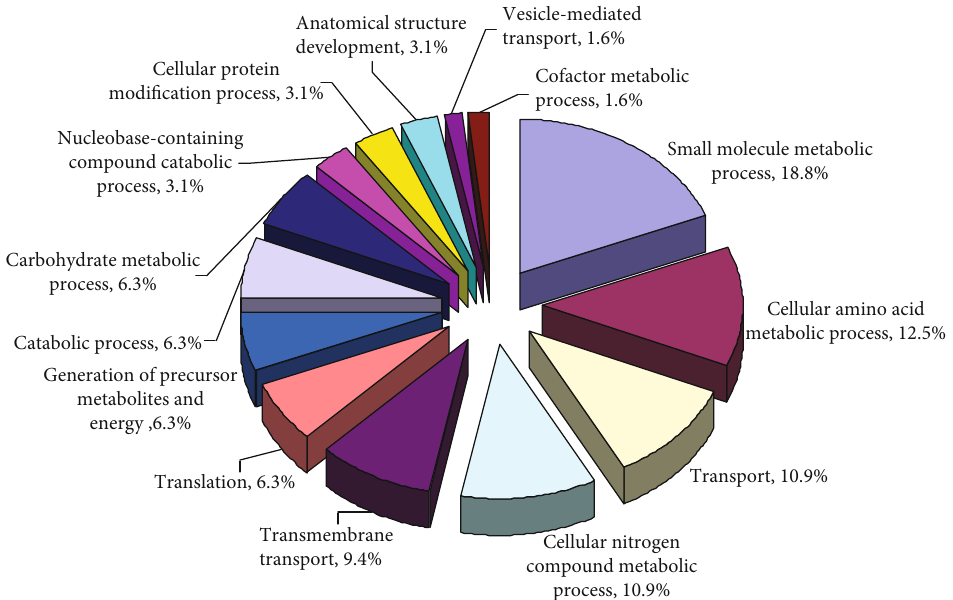
Figure 3: The biological processes of di ff erences protein of Coriolus versicolor in response to methanol extracts from the xylem of Cinnamomum camphora.